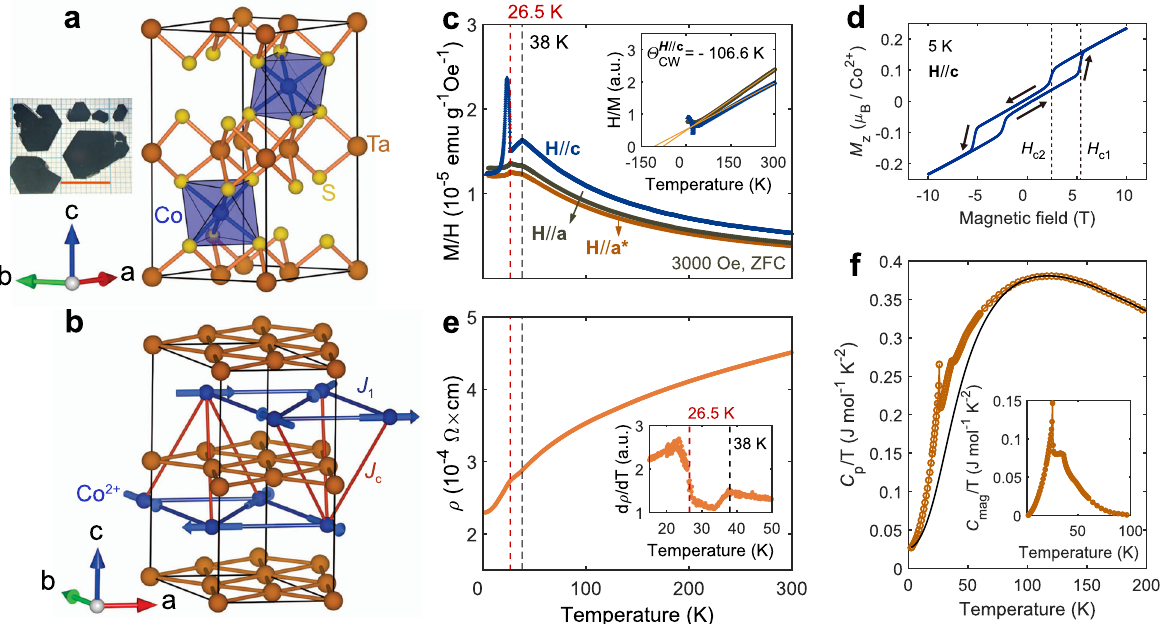
Fig. 1 Structure and bulk properties of noncollinear metallic triangular antiferromagnet Co 1/3 TaS 2 . a A crystallographic unit cell of Co 1/ 3 TaS 2 , where Co atoms are intercalated into octahedral sites. The image shows Co 1/3 TaS 2 single crystals with the solid orange line as long as 10 mm. b Noncollinear magnetic order ( Γ 2 ) formed by magnetic moments of divalent Co ions. c The magnetization of Co 1/3 TaS 2 as a function of temperature along the three crystallographic axes. The inset shows the Curie-Weiss behavior of Co 1/3 TaS 2 . d The fi eld dependence of the magnetization along the c -axis at 5 K. In addition to apparent hysteresis from weak ferromagnetic domains (± H c1 ), there is a jump of magnetization at ± H c2 . e Temperature-dependent resistivity of Co 1/3 TaS 2 where its fi rst derivative (inset) demonstrates two phase transitions, consistent with the magnetization data. f Speci fi c heat of Co 1/3 TaS 2 as a function of temperature. The inset shows the speci fi c heat after subtracting the non-magnetic contribution (see “ Methods ”